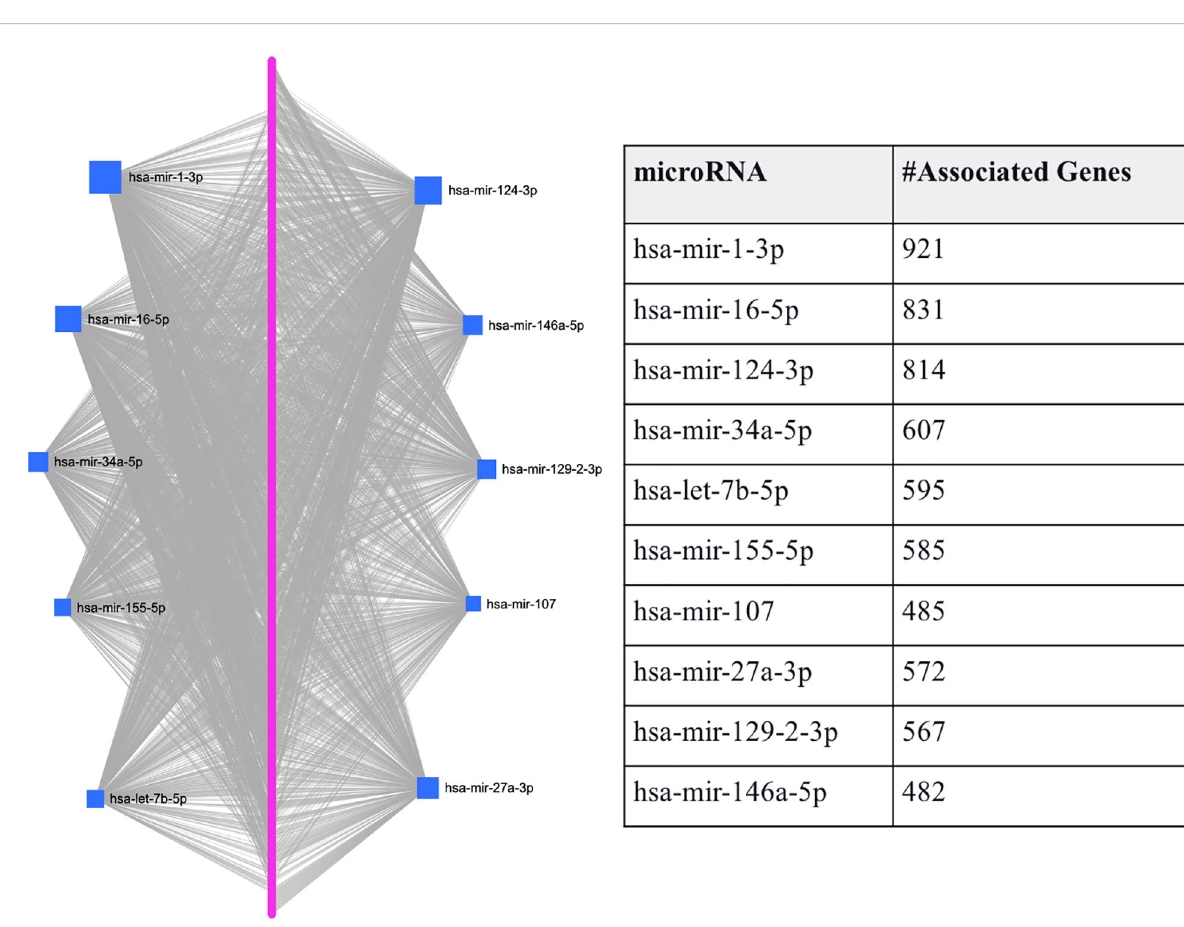
FIGURE 2 Graphical representation of the top-ranked miRNAs predicted to target T2D DEGs. The pink dots arranged linearly are a series of nodes representing the DEGs targeted by the miRNAs, while the blue squares indicate the miRNAs. The size of the square indicates the degree (the number of targeted genes); that is, the bigger the number of genes targeted by the miRNA, the bigger the size of the square.